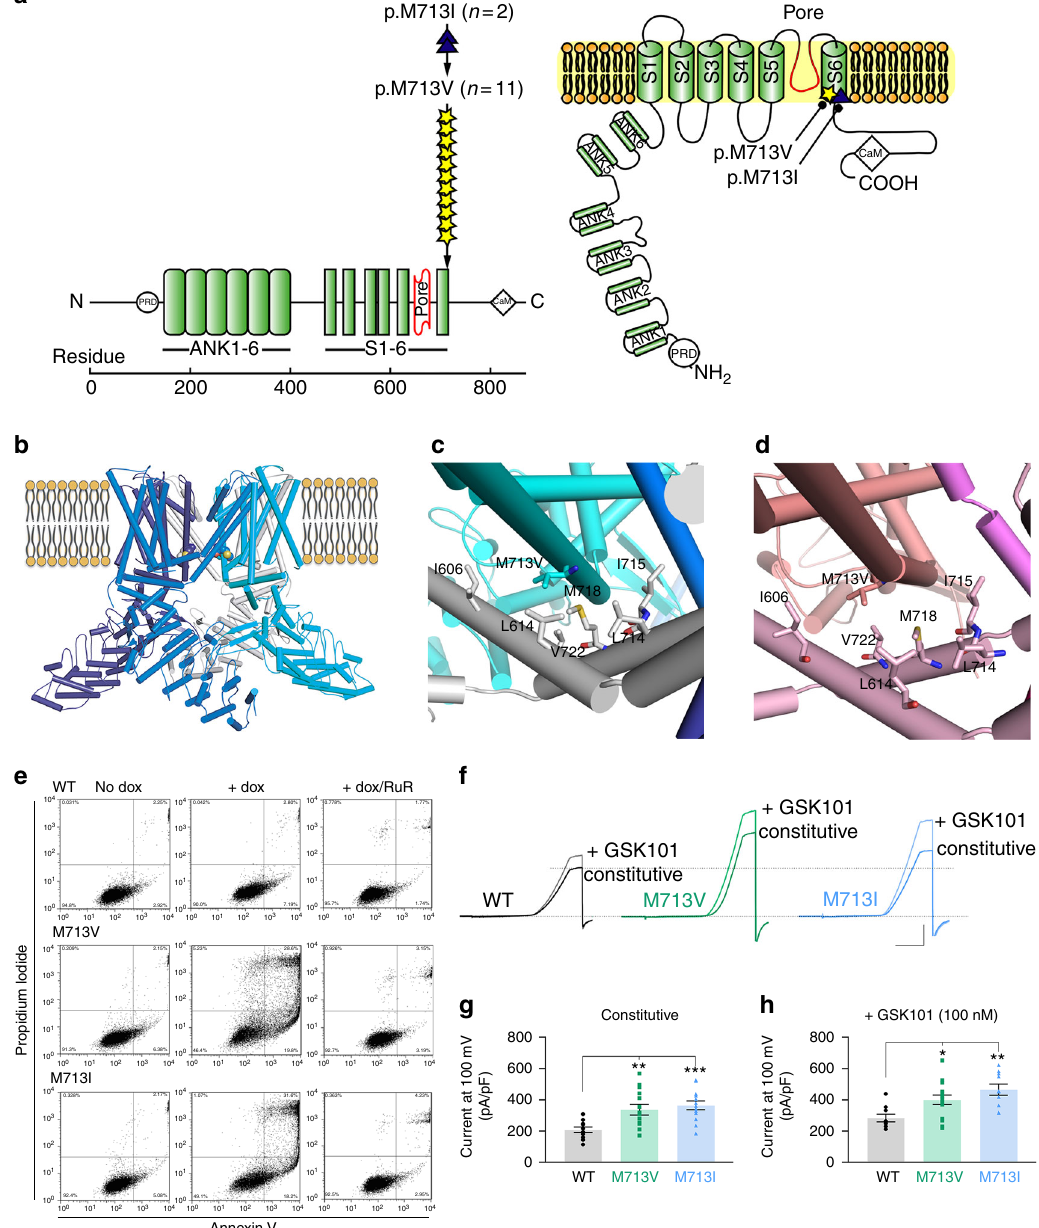
Fig. 2 TRPV4 M713 mutations in GCLJ are predicted to affect channel function and are associated with increased channel activity. a Schematic diagrams of the TRPV4 channel protein domains, including six transmembrane segments (S1 – 6), pore-forming region, ankyrin repeat domains (ANK1 – 6), proline rich domain (PRD), and calmodulin (CaM)-binding site. The position of each TRPV4 mutation detected in GCLJ is represented by a star or a triangle, along with the number of affected cases. b Model of TRPV4 protein in its homo-tetrameric closed state with the sphere representation of M713 residue within the transmembrane domain. c Closed state of TRPV1 (PDB ID:3J5P) and d open state of TRPV1 (PDB ID:5IRX), modeled with TRPV4 M713V. Surrounding hydrophobic residues are shown; residues are labeled using TRPV4 numbering. e Cell death assay on HEK293 cells expressing exogenous wild-type (WT) and mutant (M713I and M713V) TRPV4. TRPV4 mutant proteins in HEK293 cells lead to increased cell death (middle), which could be prevented by incubation with the ion channel blocker RuR (right). The percentage of cells in each quadrant is indicated as follows: lower left, live cells; lower right, early apoptosis, upper right, late apoptosis; upper left, necrosis. Representative data of three biological replicates are shown. f Representative traces of TRPV4 currents recorded in HEK293 cells before (constitutive activity) and after the application of TRPV4 agonist GSK1016790a (GSK101, 100 nM). Currents ruthenium red (RuR, 1 µ M) was included in the bath solution. Vertical scale bar, 100 pA/pF; horizontal scale bar, 100 ms. g Individual-value plots of outward current recorded at 100 mV in the absence of GSK101 (mean ± s.e.m, ** P < 0.01, *** P < 0.001, one-way ANOVA followed by Dunnett ’ s